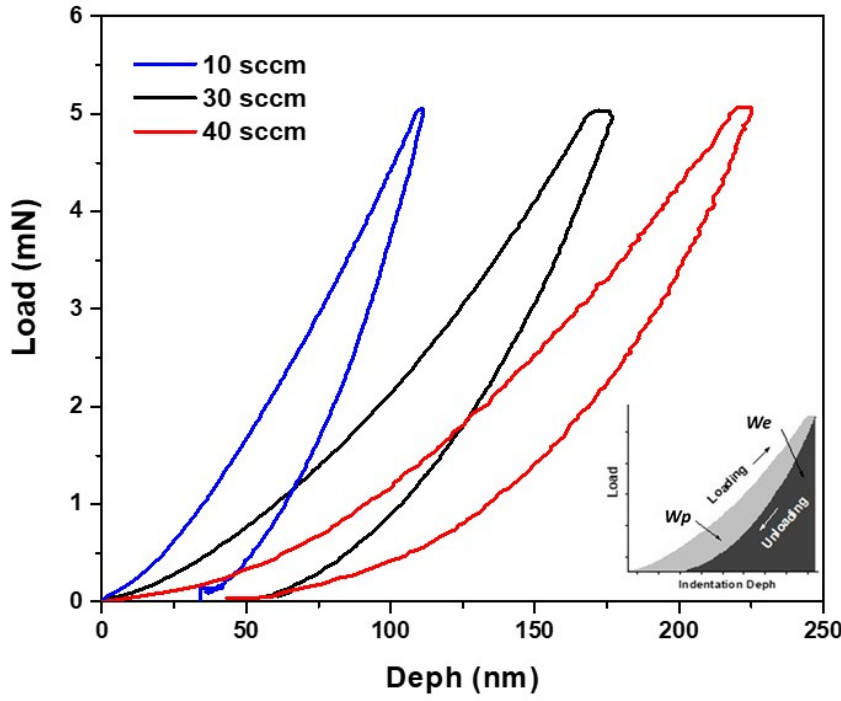
Figure 6. Typical indentation curves for coatings deposited with three different flows of CH 4 .